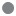
Serum bactericidal responses induced in individual mice immunised with NOMV or recombinant fHbp.Mice were immunised twice with NOMV (A-E), or with recombinant fHbp (F-I), four weeks apart, as described in the materials and methods. Serum samples obtained two weeks after the second dose were tested against a set of seven strains, expressing the four different fHbp ID types: ID 1 (●), ID 5 (▲), ID 9 (■), or ID 74 (▼). Each symbol represents the reciprocal titre of an individual mouse; horizontal bars represent geometric mean titres of the group.